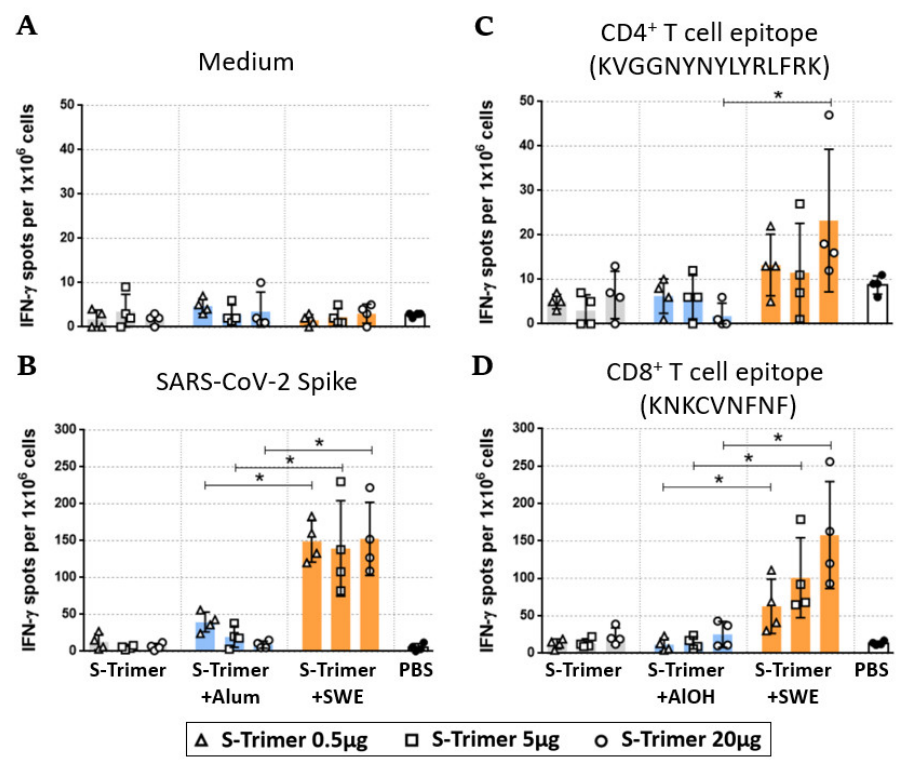
Figure 5. Spike-specific T-cell responses to adjuvanted S-Trimer immunization in BALB/c. Spleens were collected from the PBS control or immunized BALB/c mice ( n = 4/group) two weeks after the second vaccination. Splenocytes from each individual were ( A ) cultured in medium as control or stimulated with ( B ) SARS-CoV-2 spike ectodomain, ( C ) CD4 + T-cell epitope, or ( D ) CD8 + T-cell epitope. The number of IFN- γ -secreting cells was evaluated by ELISpot assay. Each symbol represents individual mice; each bar represents the mean ± SD of each group for ELISpot assay. Statistically significant differences were compared by two-tailed Mann–Whitney test. * p < 0.05 was considered significant; ns: not